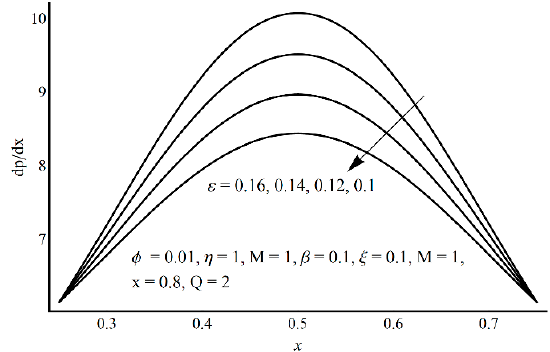
Figure 6. Axial velocity for various values of fluid material parameter η .